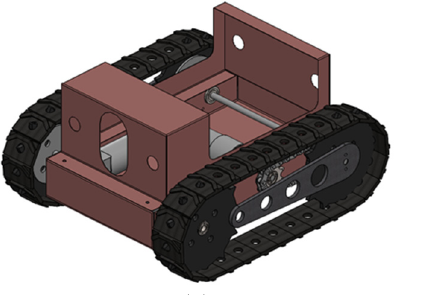
Figure 1. 3D model of the hybrid robot: ( a ) 3D view; ( b ) front view; ( c ) side view.